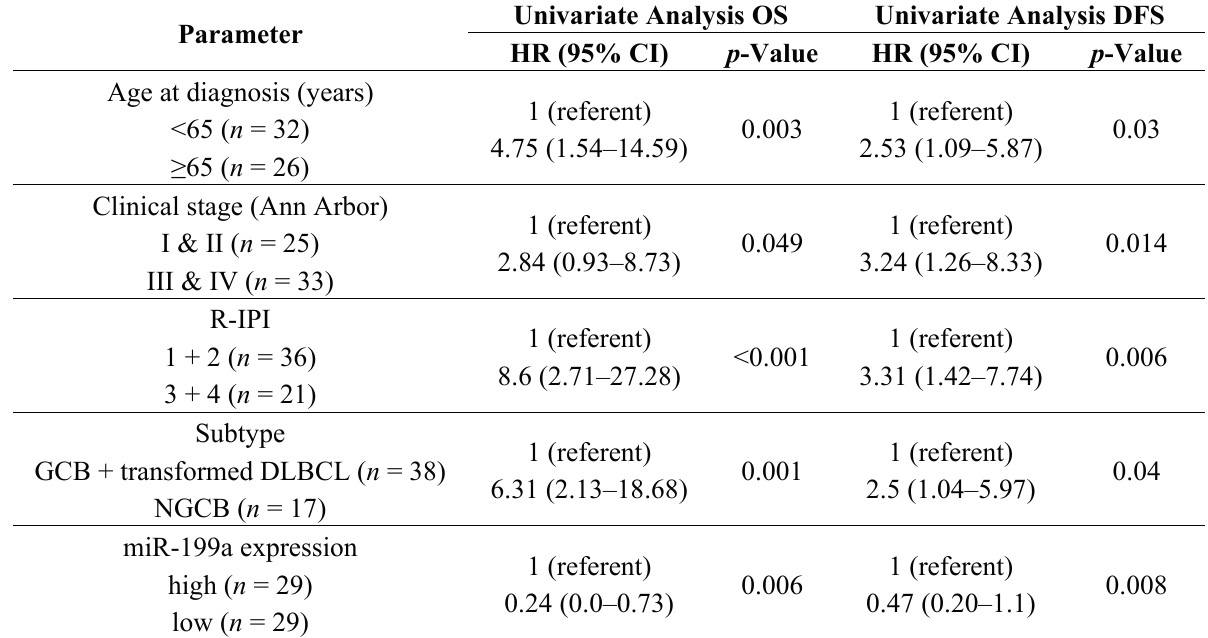
Table 3. Univariate analysis of clinicopathological parameters for the prediction of overall survival (OS) and disease free survival (DFS) in our patient cohort ( n =